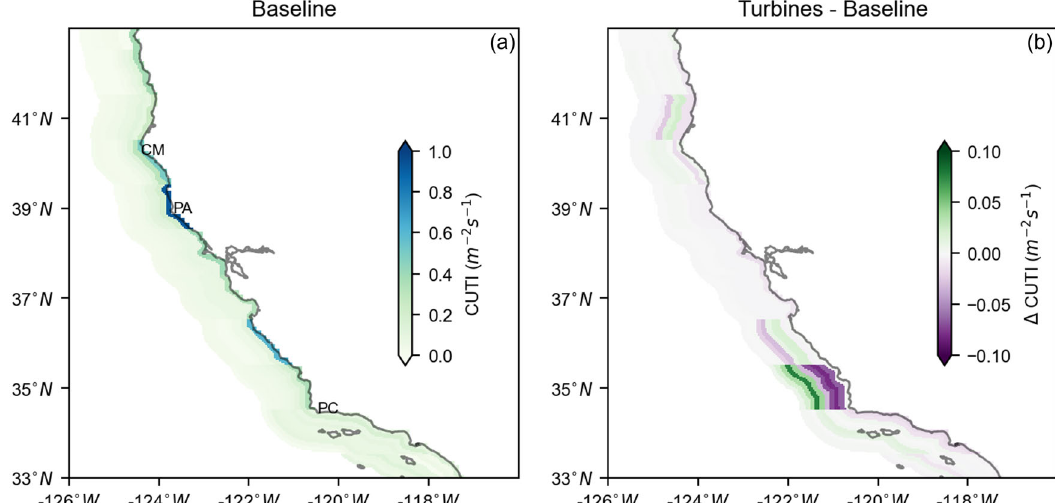
Fig. 5 Interannual mean of Coastal Upwelling Transport Index (indicating the strength of upwelling). Coastal Upwelling Transport Index (CUTI) for a baseline, and, b with turbines. CUTI shows a decrease in upwelling with the presence of turbines particularly nearshore (dark purple) and an increase offshore (green) at 35°N latitude. Marked on the maps are Cape Mendocino (CM), Point Arena (PA), and Point Conception (PC). COMMUNICATIONS EARTH & ENVIRONMENT| (2023) 4:116